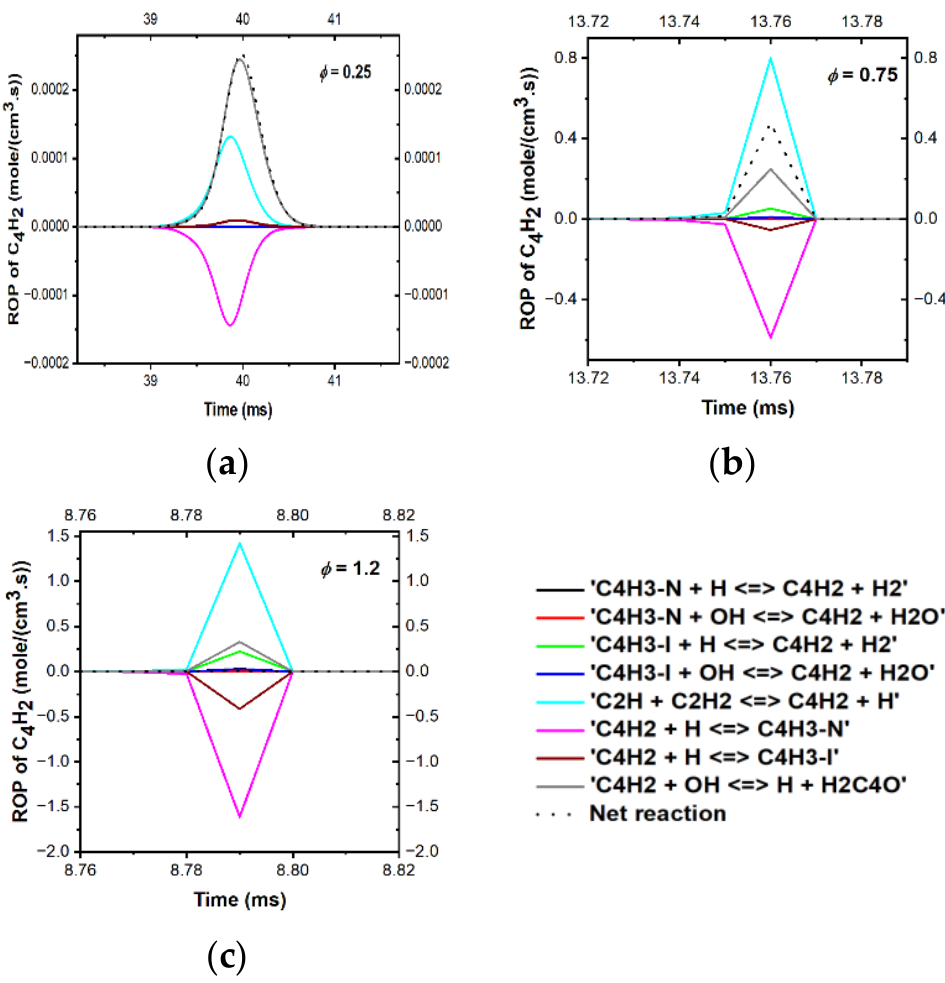
Figure 21. ROP analysis of C 4 H 2 for the oxidation of tert-butanol at ( a ) φ = 0.25, ( b ) φ = 0.75 and ( c ) φ = 1.2.